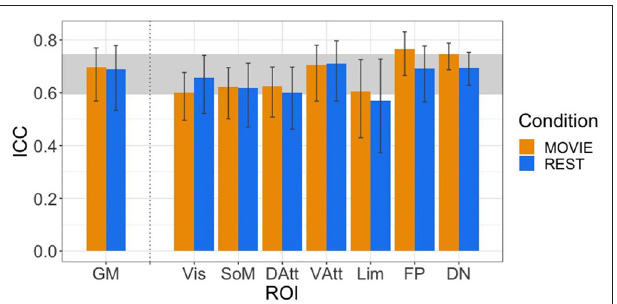
FIGURE 4 | ICCs of H across resting state runs and different movies. GM shown on left, with the seven RSNs on the right (separated by vertical dashed line). Vertical black bars represent 95% confidence intervals. Horizontal gray band in background represents good test-retest reliability (0.60 < ICC < 0.74).